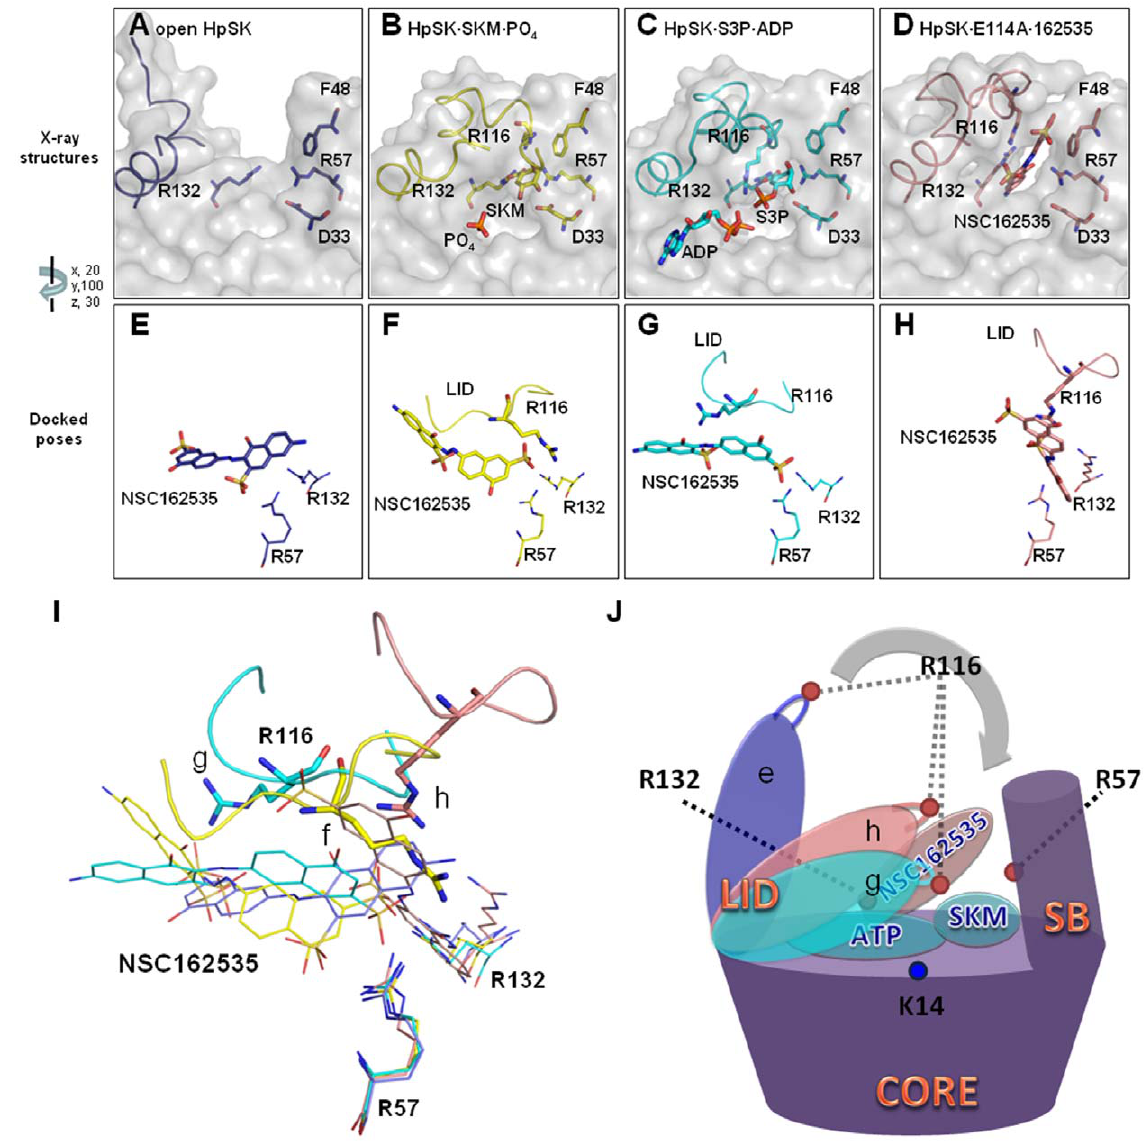
Figure 5. Probing the binding pockets in HpSK. (A–D) The binding pockets of HpSK: (A) open HpSK (3HR7), (B) HpSK ? shikimate ? PO 4 (1ZUI), (C) HpSK ? S3P ? ADP (3MUF), and (D) E114A ? 162535 (3N2E). The bound ligands, D33, F48, R57, R116, and R132 are drawn as sticks. The LID segments (residues 109–123) are drawn as ribbon structures. (E–H) The docked NSC162535 models in the binding pockets of HpSK: (E) open HpSK, (F) HpSK ? shikimate ? PO 4 , (G) HpSK ? S3P ? ADP, and (H) E114A ? 162535. Superposition of the three residues R57, R116, and R132, docked and bound to NSC162535 with open HpSK (blue), HpSK ? shikimate ? PO 4 (yellow), HpSK ? S3P ? ADP (cyan), and E114A ? 162535 (pink). (I) Superimposed docked structures (E–H). The conformation of the LID segment (residues 113–119, shown as ribbon) and R116 (thick stick) demonstrates the greatest conformational changes induced by bound ligands. (J) Schematic diagram of induced-fit conformational changes upon ligand binding. The view of LID regions corresponding to open HpSK (e), HpSK ? S3P ? ADP (g), and E114A ? 162535 (h) are colored as blue, cyan, and pink, respectively.